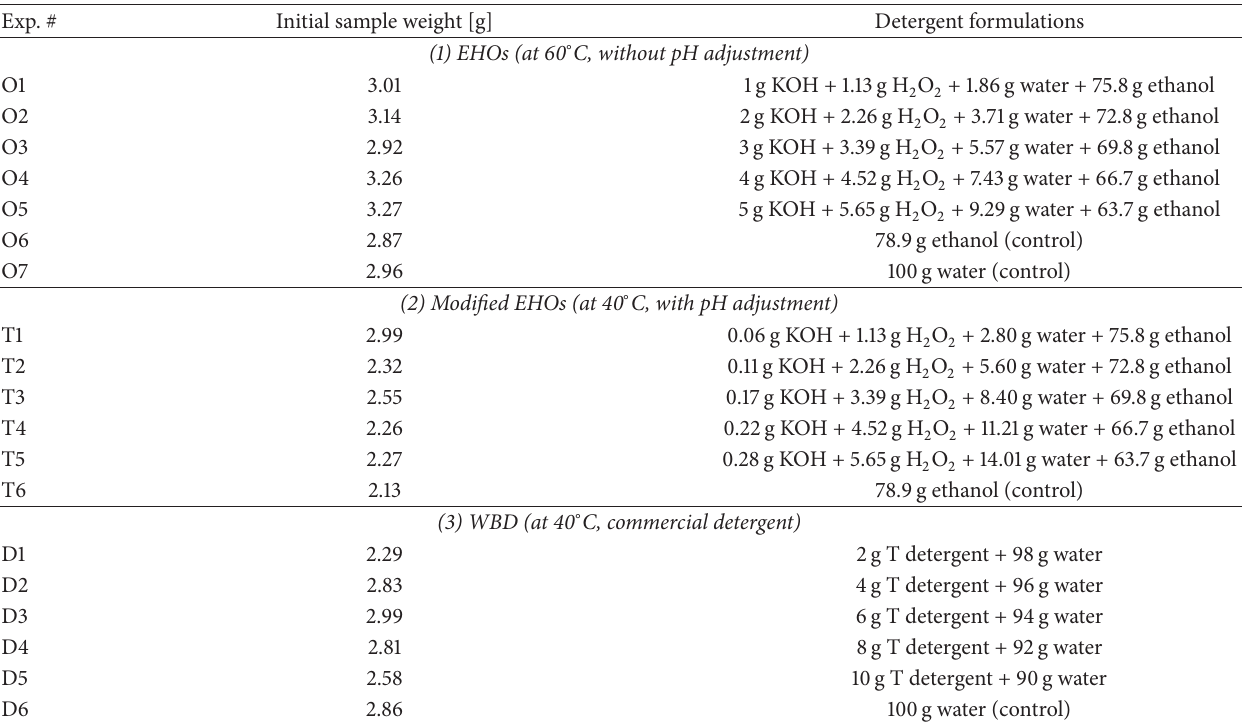
Table 2: Detergent